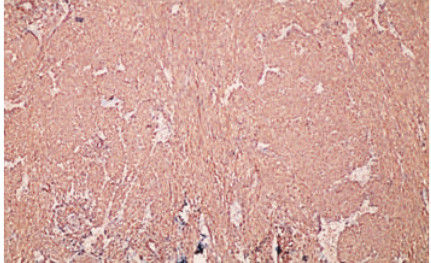
Figure 2: Histopathology slide shows cellular, nodular neoplasm consisting from benign smooth muscle cells with spindle shaped nuclei, eosinophilic cytoplasm (L: Lumen, RV: Renal vein, T: Tumour; H&E × 100).